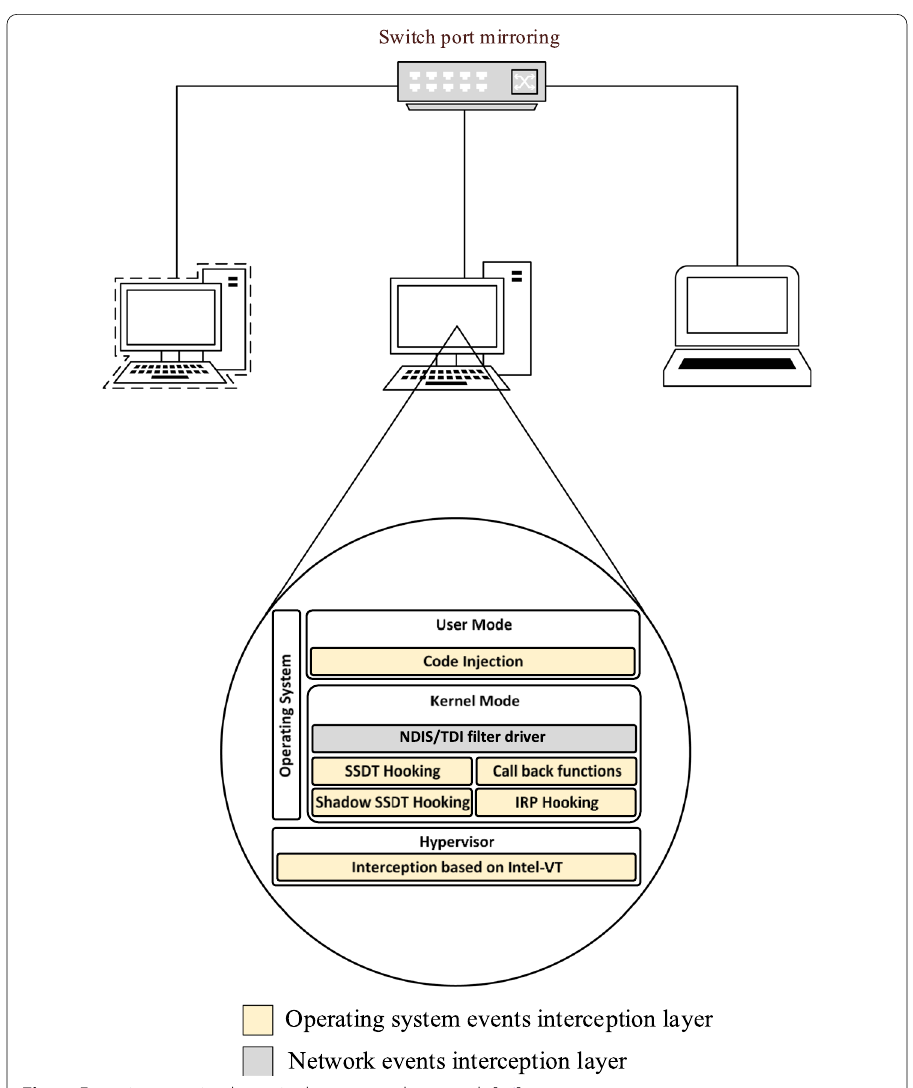
Fig. 7 Event interception layers in the proposed approach